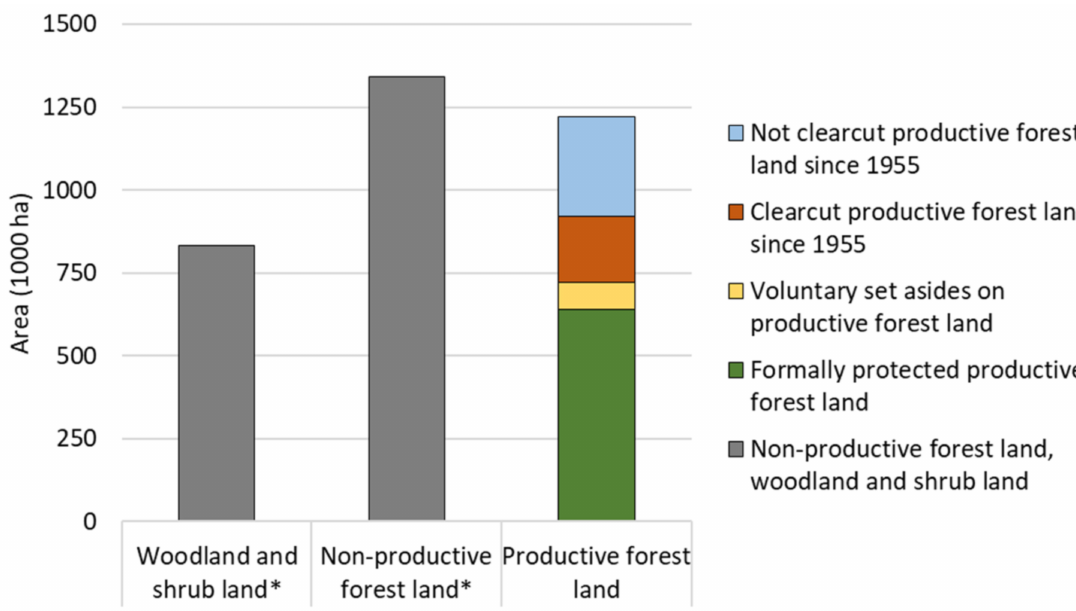
Figure 8. Area distribution in the region above the mountain forest border of woodland and shrub land (*), non-productive forestland [53], protected productive forestland [50], clear-cut productive forestland since 1955 [57], and not clear-cut productive forestland since 1955. Data on productive forestland (1221 × 10 3 ha) is according to NMD [53]. * Data on woodland and shrub land is our interpretation of the di ff erence between two forests layers (one from NMD [54] and one from the National Land Survey) and should be regarded as provisional. Open land can occur to some extent in both categories, and the division between the two categories is not firmly